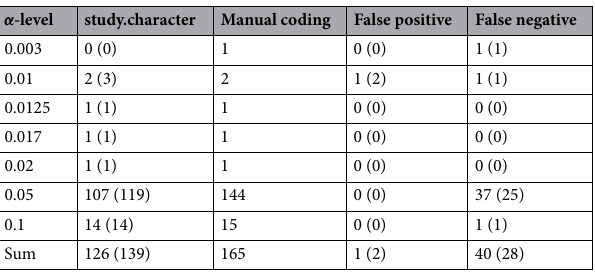
Table 5. Distribution of extracted maximum α -level with option ‘p2alpha’ deactivated and in default mode (numbers in brackets).